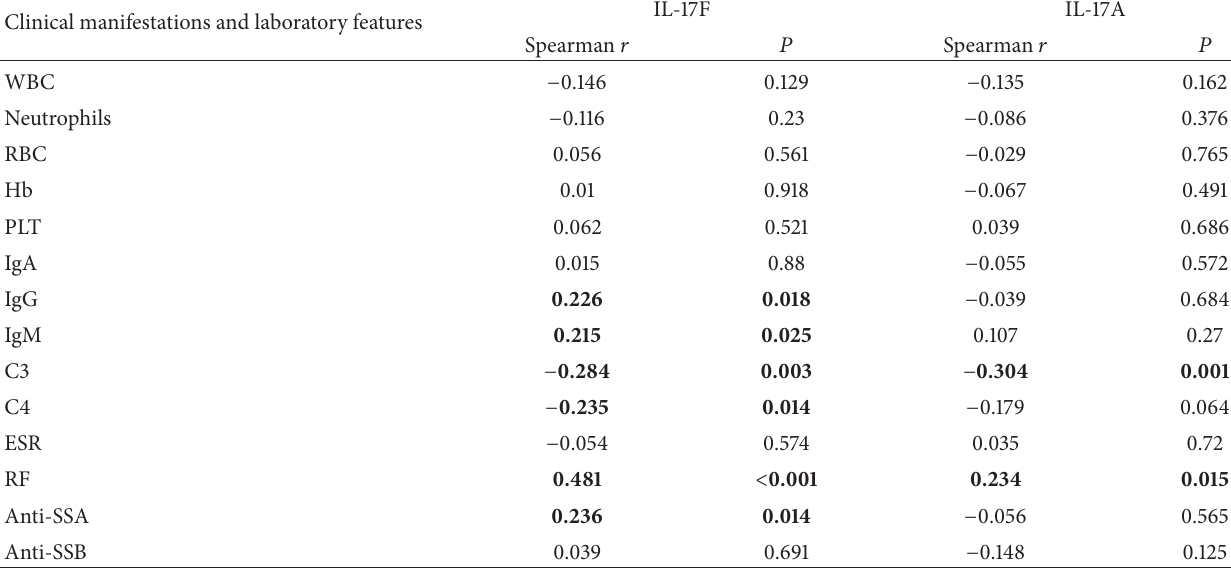
Table 2: Correlation of serum IL-17F and IL-17A with clinical and laboratory features of pSS patients. Clinical manifestations and laboratory features